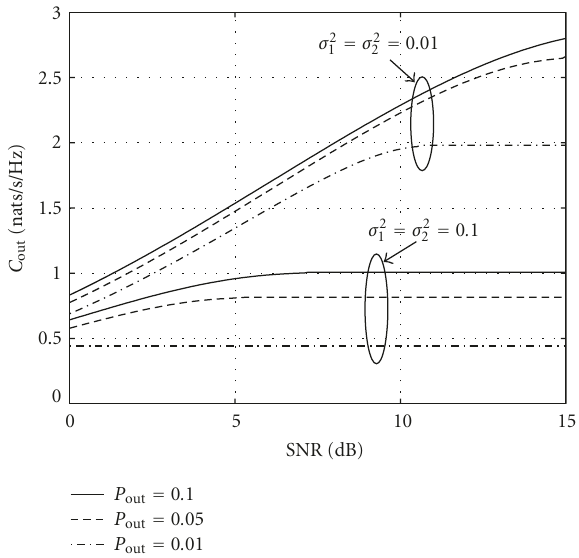
Figure 5: Lower bounds on the outage capacity of D-STBCs with single receive antenna.